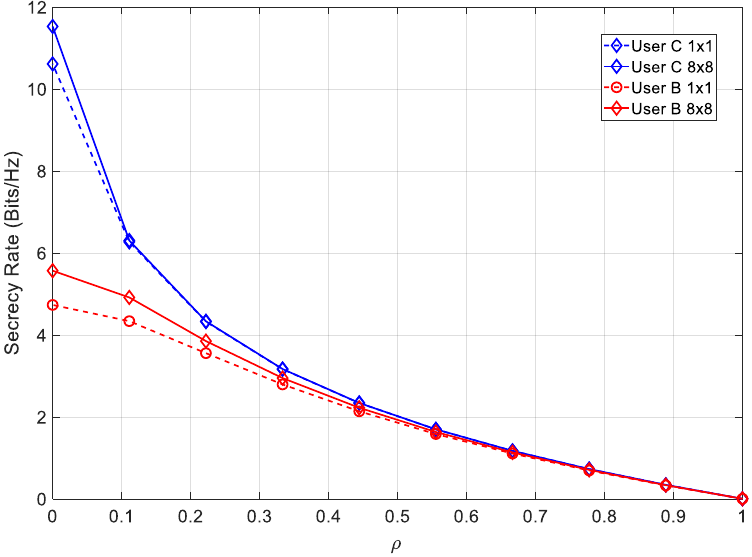
Figure 5. Secrecy rate for SISO and MIMO configurations considering perfect channel estimation. In this graph, ρ refers to either ρ EB or ρ EC , according to the user in